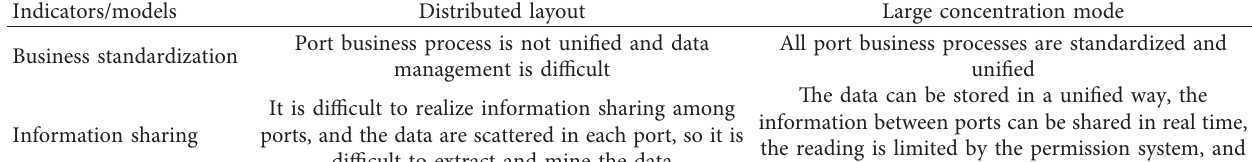
Table 1: Comparison of technical advantages between decentralized layout and centralized mode.